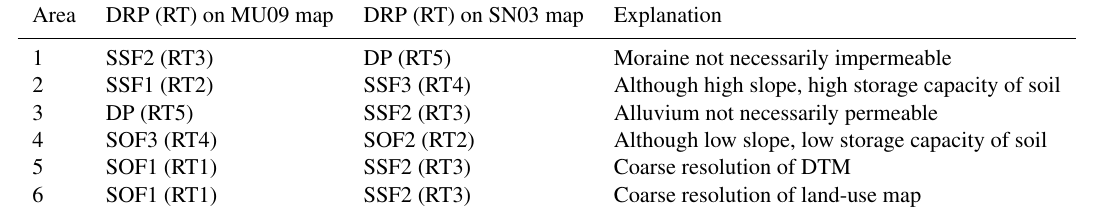
Table 4. List of areas identified in Fig. 8 with the automatically and manually derived DRPs (RTs), and a possible explanation for their deviation.